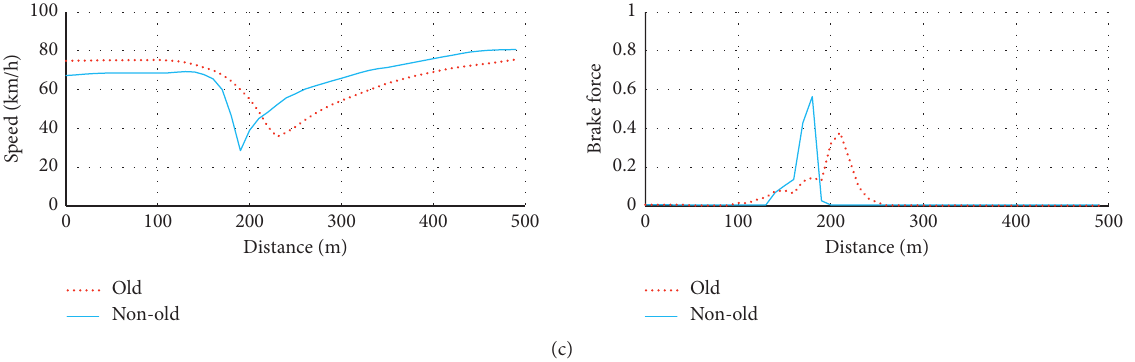
Figure 4: Comparison of driving behaviors according to age for incident #3 in the daytime experiment. (a) Group 1 (passed both static and dynamic vision tests). (b) Group 2 (passed the static vision test but failed the dynamic vision test). (c) Group 3 (failed both static and dynamic vision tests).